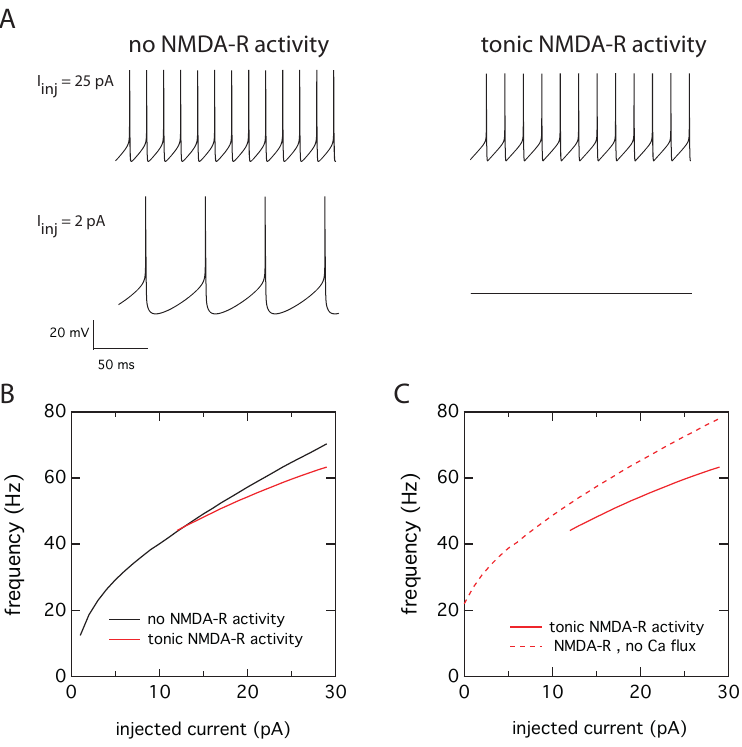
Figure 2. Decreased intrinsic excitability in presence of tonic NMDA-R activity. ( A ) The presence of tonic NDMA-R activity increases the threshold current for action potential generations and decreases the firing frequency for an injected current of 25 pA. ( B ) Corresponding current-frequency plots in absence (black) and presence of a tonic NMDA-R activity (red). ( C ) Hyperexcitability is observed when the I NMDA , Ca term is suppressed from the Ca 2 + balance equation (dotted line), compared to the current-frequency curve obtained with a Ca 2 + influx through the NMDA-R (red line, same as in (B)). The decreased intrinsic excitability in presence of tonic NMDA-R activity is therefore mediated by the Ca 2 + influx through these